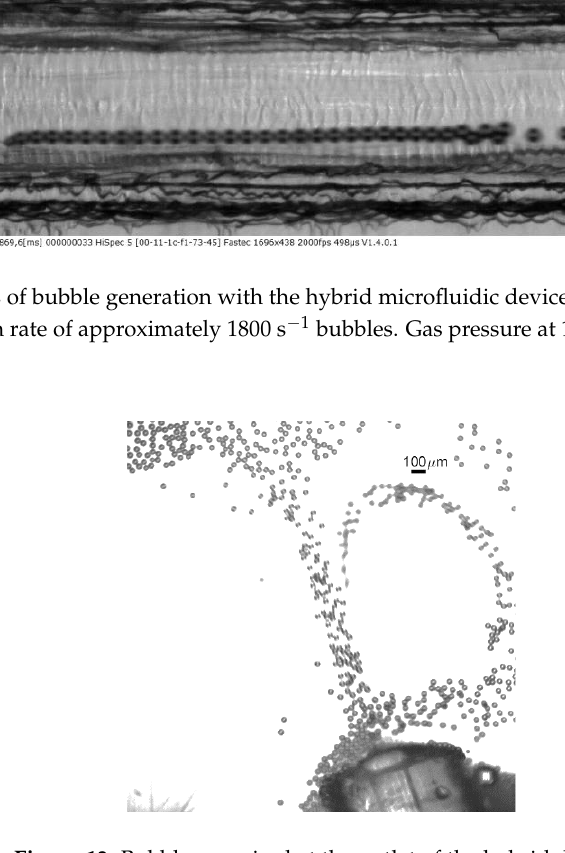
Figure 12. Process of bubble generation with the hybrid microfluidic device with hybrid microfluidic device, production rate of approximately 1800 s − 1 bubbles. Gas pressure at 1.04 bar and liquid flow in 1.55 mL·min − 1 .